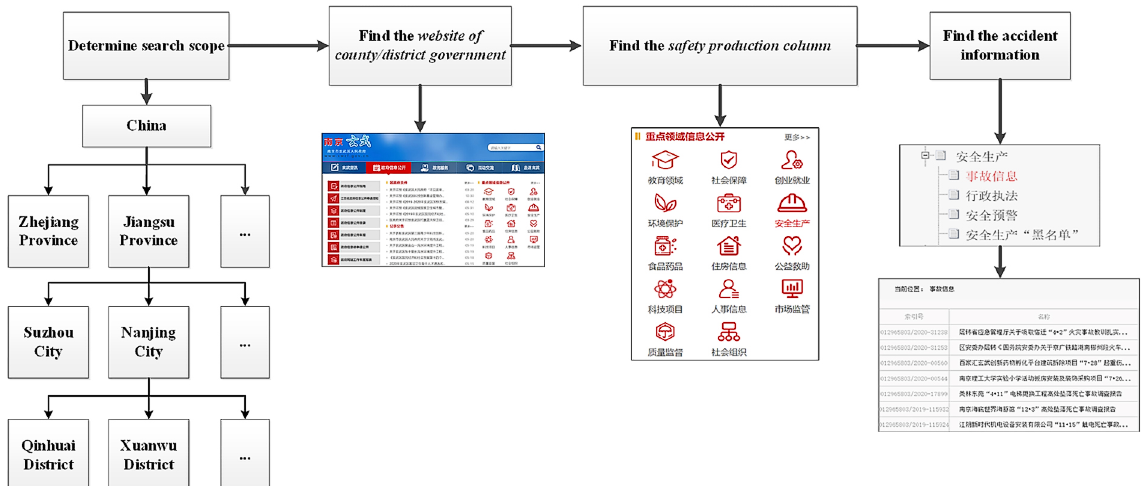
Figure 2. An example of the accident search